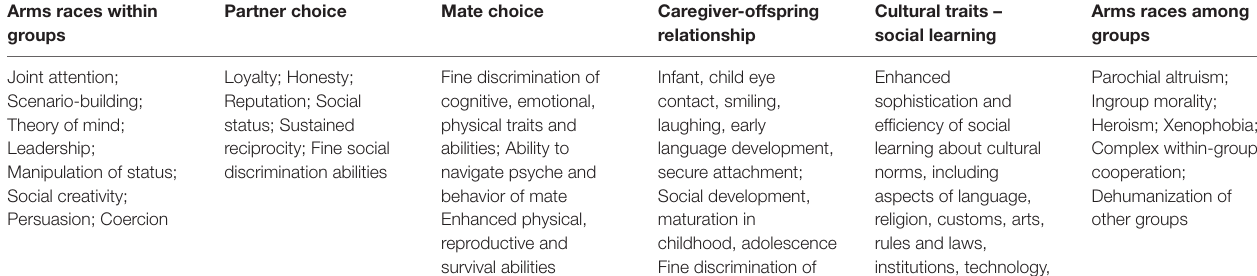
Cultural traits – Arms races among relationship social learning groups